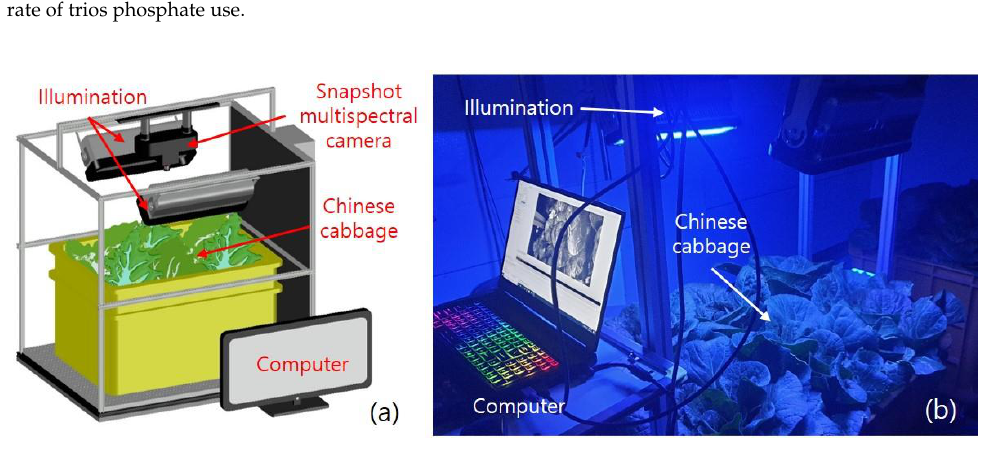
Figure 1. ( a ) Conceptual diagram of the newly developed visible-near infrared snapshot-based multispectral imaging system and ( b ) a photo of the experimental setup. The total number of image pixels in the SMI camera was 2048 × 1088 pixels. Halogen lamps were selected because they emit a continuous spectrum of light from near-ultraviolet to deep infrared. Cooling fans were installed at the end of the halogen lamps for ventilation because of the high radiant energy produced by the illumination during the imaging process. When taking the sample images, the exposure time was optimized using the auto exposure time function provided by commercial software (BaySpec SpecFrabber; BaySpec Inc., CA, USA) to avoid saturation of the pixel intensity. The commercial software acquired the spectral data of sample images in the form of a 3D spectral data cube consisting of two spatial dimensions (x- and y-directions) and a single spectral ( λ ) dimension. The dimensions of the spectral data cube were 400 pixels in the x-direction, 200 pixels in the y-direction, and 38 bands (wavelength) in the λ -direction. The number of visible and NIR bands used was 16 and 22, respectively. In addition, sample images were acquired every four days to analyze the heat stress damage during